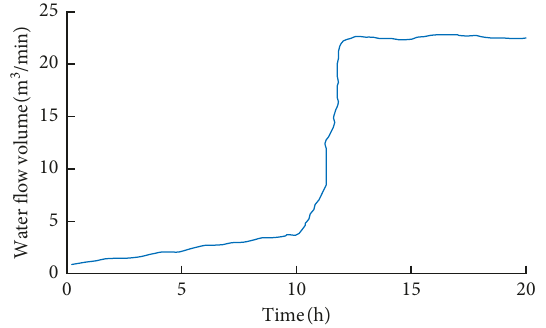
Figure 10: Curve of the water flow volume for a